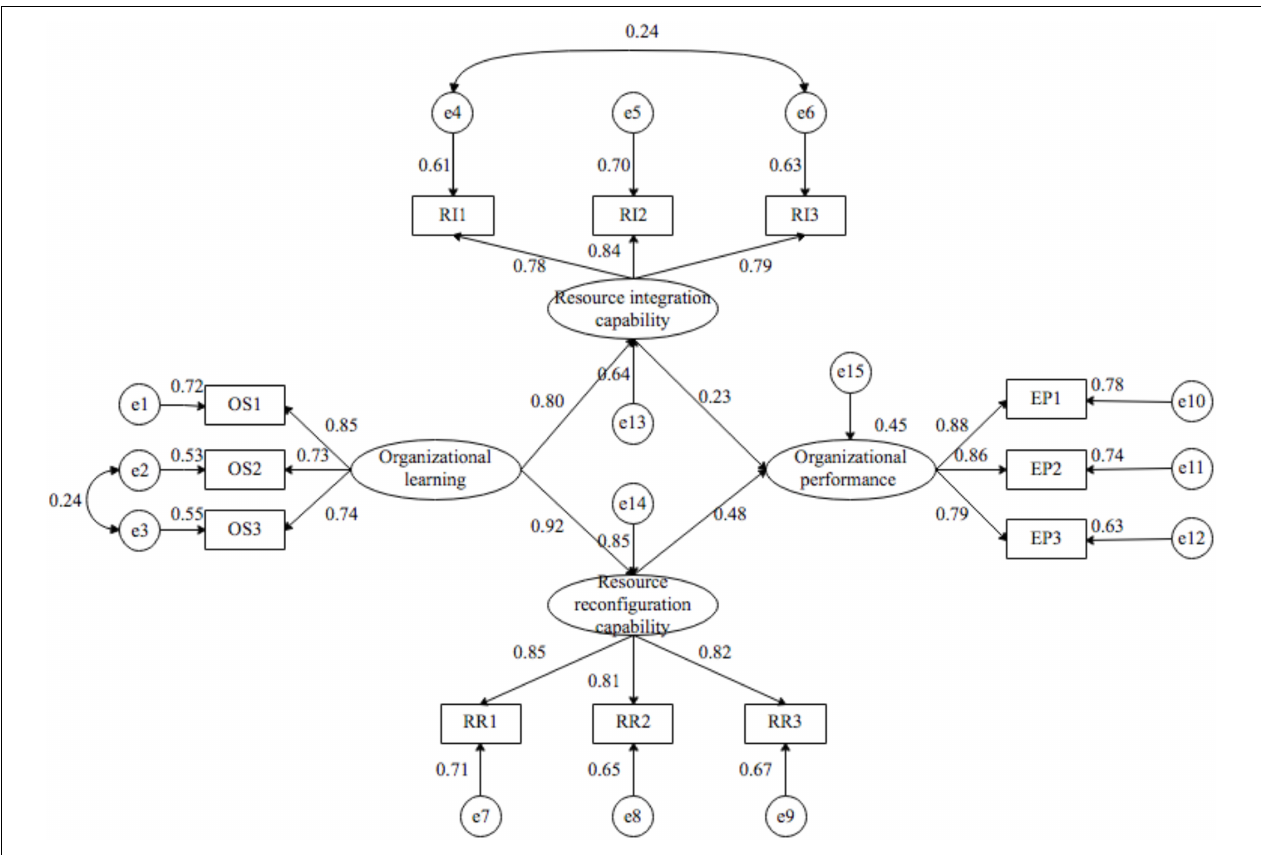
FIGURE 2 | Model path diagram of organizational learning, dynamic capability, and organizational performance.